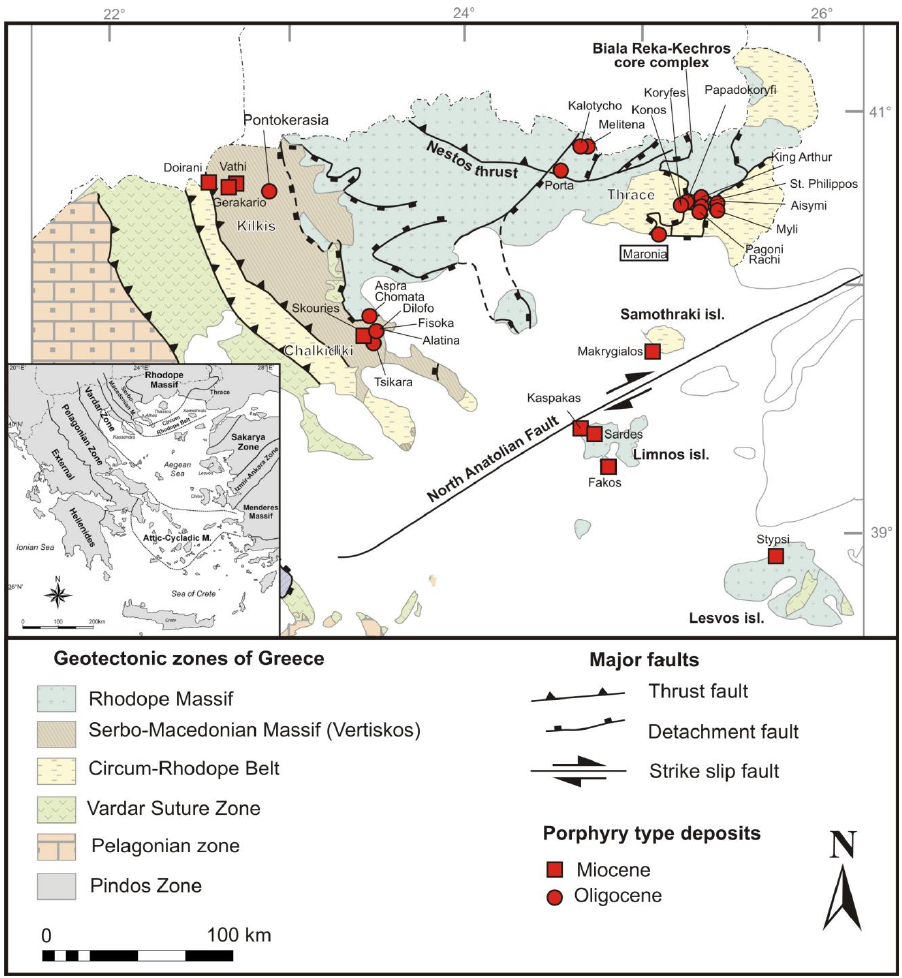
Figure 1. Simplified map of Northern Greece showing the main geotectonic zones, the major tectonic structures within the Hellenides, and the distribution of porphyry-type deposits (after Melfos and Voudouris [8]; Voudouris et al. [9]). The Maronia area is outlined and the geotectonic zones of the Hellenic orogen are shown in the inset.